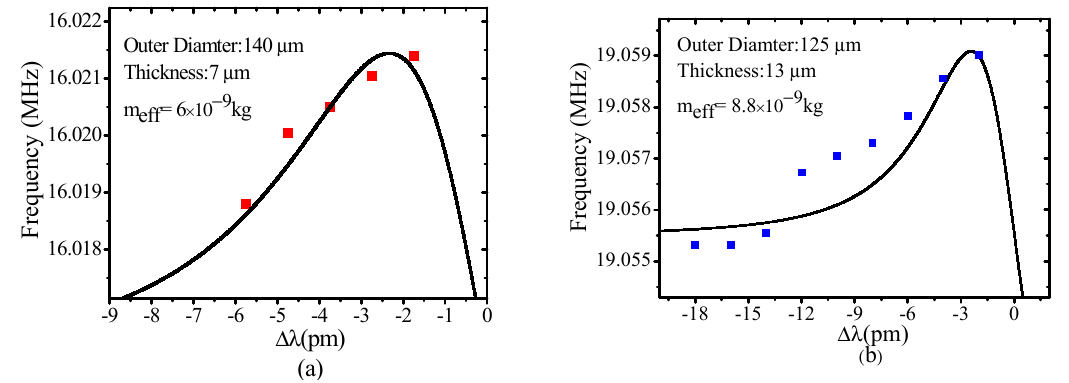
Figure 4. The OSE measurements of two MBRs with different wall thickness. ( a ) MBR outer diameter 140 μ m and wall thickness 7 μ m; ( b ) MBR diameter 125 μ m and wall thickness 13 μ m. Dots are the experimental results, and solid lines are simulated results. Effective masses of 6 × 10 − 9 kg and 8.8 × 10 − 9 kg are obtained.